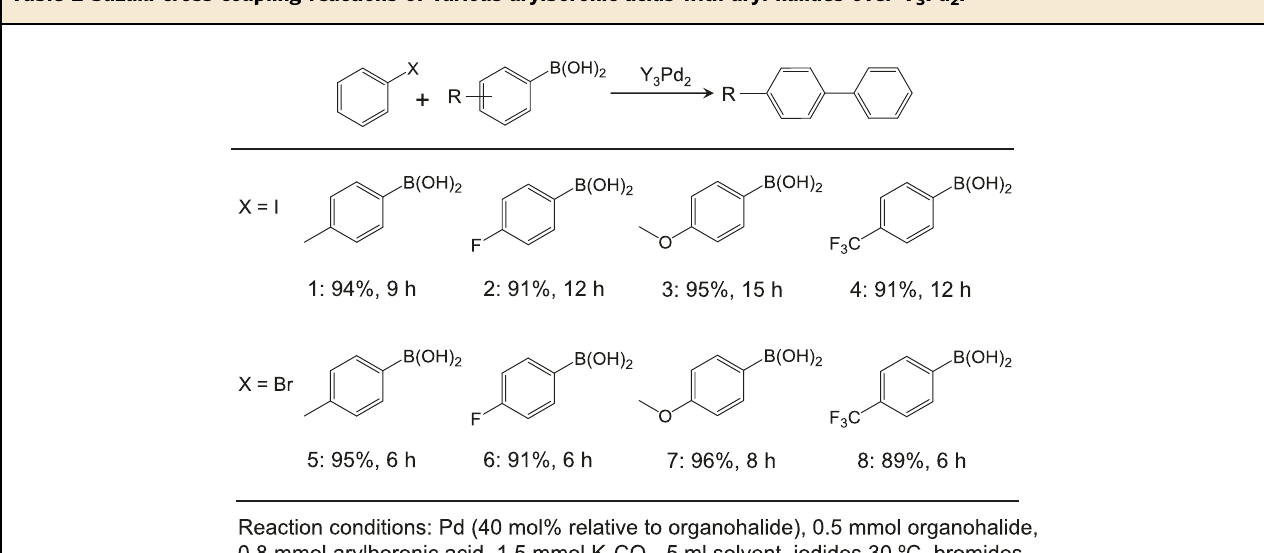
Table 2 Suzuki cross-coupling reactions of various arylboronic acids with aryl halides over Y 3 Pd 2